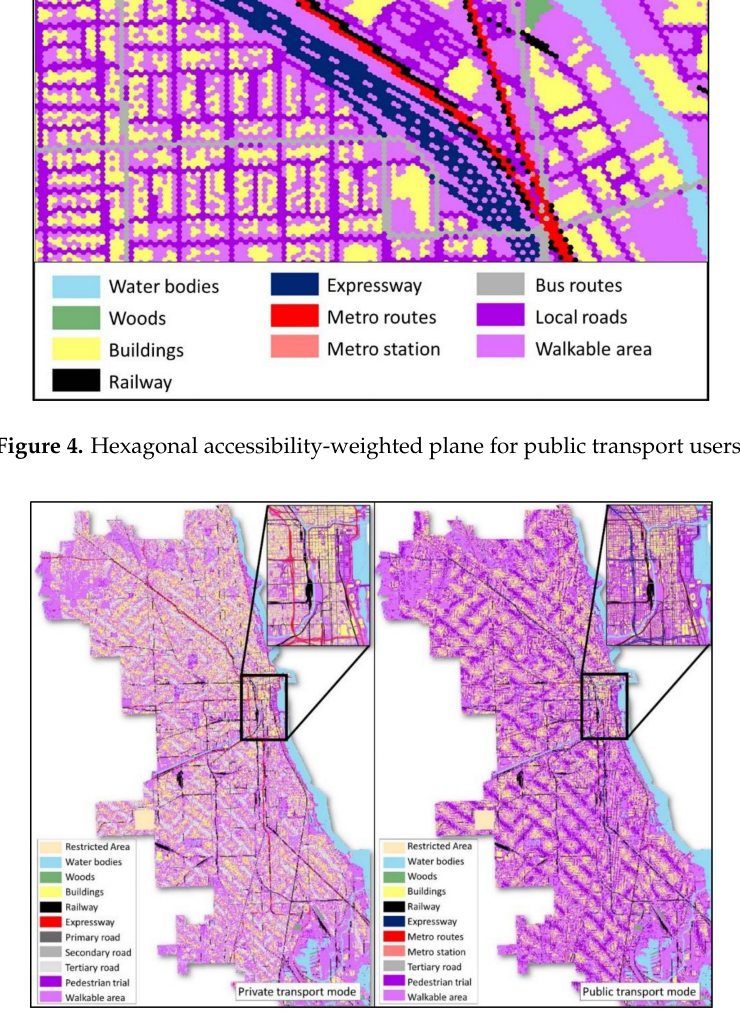
Figure 5. The context-based hexagonal accessibility-weighted plane of